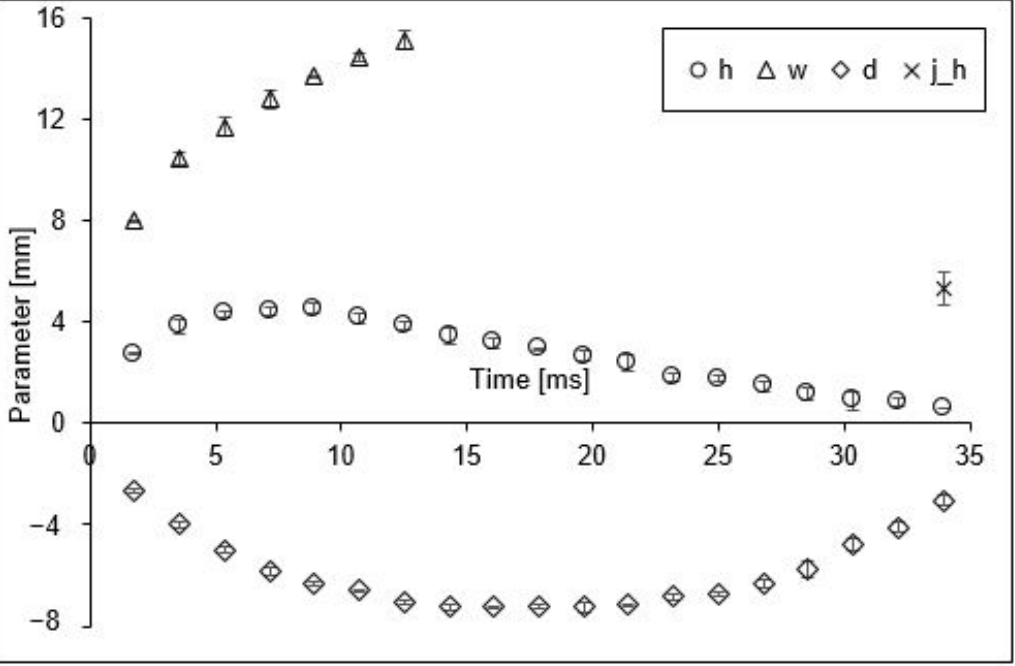
Figure 4. Size of the splash expressed through the parameters of the generated forms: crown height (h), external width of the crown (w), depth of the cavity below the water surface (d), and jet height (j_h), presented in subsequent moments of the splash phenomenon after the impact of a petrol drop falling from 0.7 m. The negative values of the cavity parameters are the consequence of the assumption that the water level was the reference.